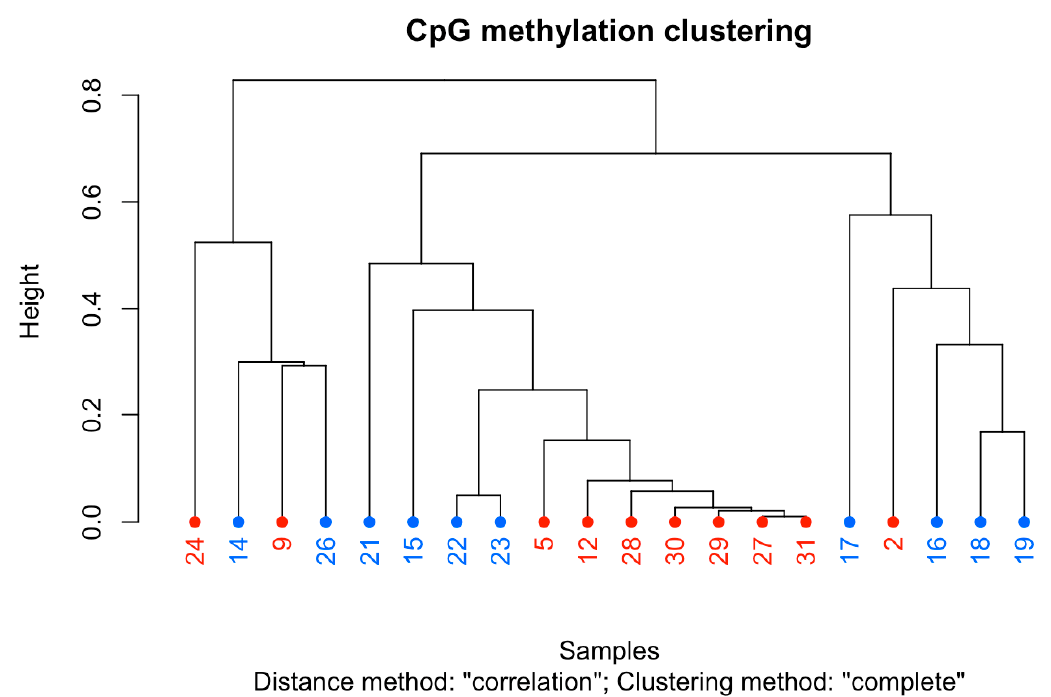
Figure 4. Hierarchical cluster analysis according to methylation patterns across analysed samples. Blue colour—low cloning efficiency cells; red colour—high cloning efficiency cells. Dendrograms were produced using correlation distance and ward clustering methods. Numbers represent the individual sample ID.